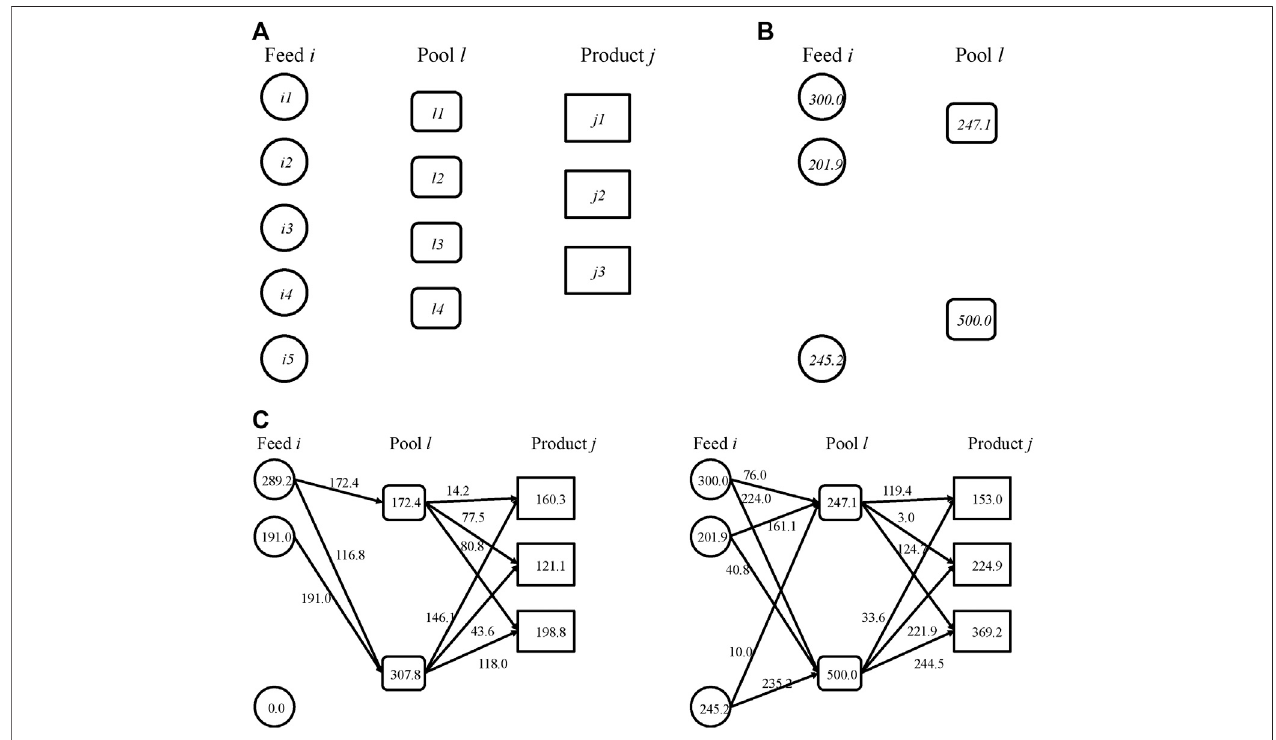
FIGURE 6 | Stochastic pooling problem (A) is the superstructure of the pooling problem (B) is the optimal fi rst-stage decisions for the pooling example (C) represents the optimal mass fl ow rates in the low-demand scenario (left) and the high-demand scenario (right).